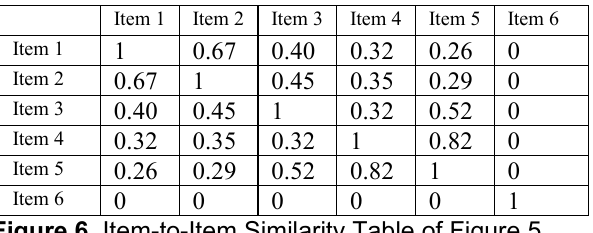
Figure 5. User-Item Rating Matrix